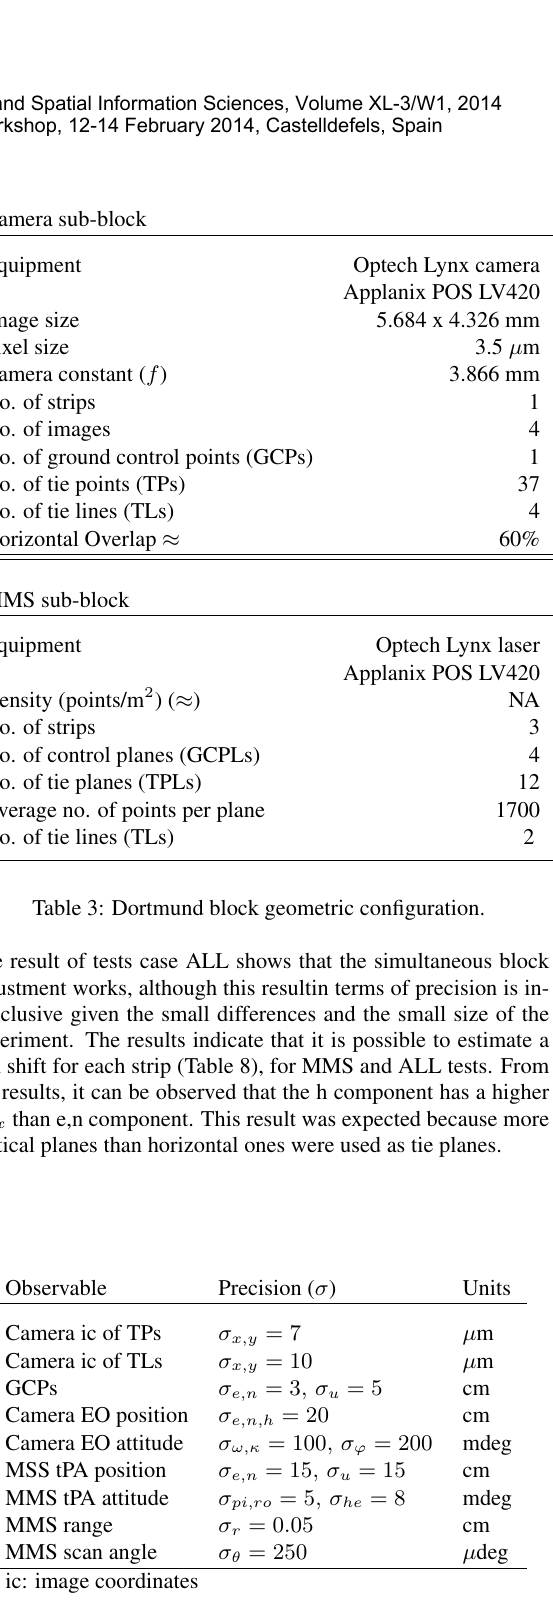
Table 4: Precision of the